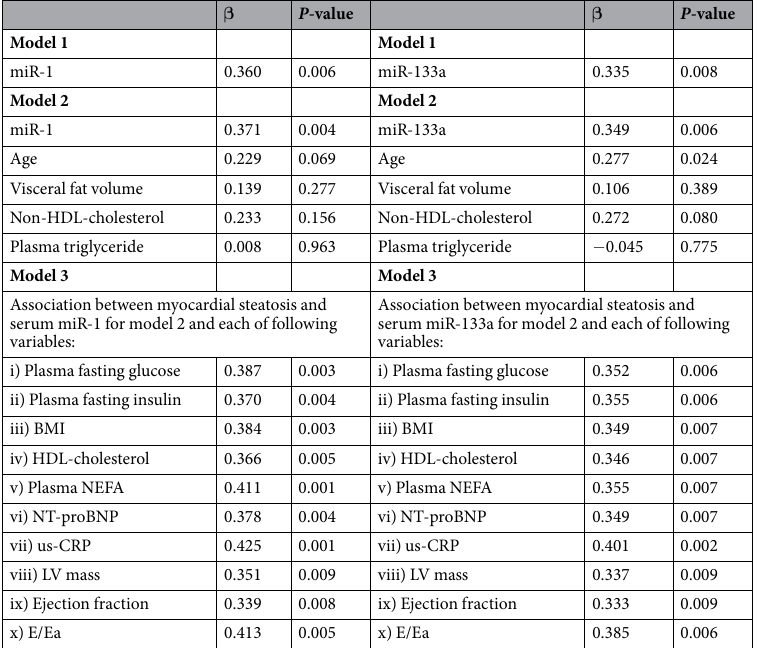
our clinical findings in an animal model of insulin resistance induced by a high-fat diet. Body composition and biochemical parameters for both groups of animals are shown in Table S2 (Supplementary Information). Six weeks of Western diet significantly increased fasting plasma glucose and insulin levels, as well as the insulin resist- ance index (HOMA-IR) (Fig. 2A). A glucose tolerance test in mice fed on a Western diet revealed delayed glucose clearance as compared with those fed on a chow diet. As expected, the accumulation of neutral lipid content in the myocardium was significantly higher in mice fed on a Western diet as compared with those on a normal chow diet (Fig. 2B). No differences in cardiac function parameters were observed between study groups (p < 0.050 for all parameters). After demonstrating an increase in myocardial neutral lipid accumulation in our murine model of insulin resistance, we next analysed levels of miR-1 and miR-133a in the serum and myocardium of both diet groups. Corroborating our clinical findings, we observed increases in serum levels of miR-1 (3.3-fold) and miR-133a (2.4-fold) in the Western diet group with respect to the chow diet group (Fig. 2C). Myocardial levels of miR-1 and miR-133a were similar in both groups (Fig. 2D). A correlation between the myocardial neutral lipid content and circulating levels of miR-1 and miR-133a was observed ( ρ = 0.622, P = 0.031, ρ = 0.755, P = 0.005, respectively). Circulating cardiomyocyte-enriched miR-1 and miR-133a are released by HL-1 cardiomyo - cytes following intracellular neutral lipid accumulation. Our clinical and in vivo findings suggest that lipid oversupply to the myocardium may underlie the observed alterations in serum miR-1 and miR-133a levels. Therefore, we used an in vitro model to investigate whether the accumulation of neutral lipids in HL-1 cardiomyocytes induces the release of miR-1 and miR-133a. As previously demonstrated by our group 28, 29 , expo- sure to VLDL + IDL (50 or 100 μ g/mL) dose-dependently increased intracellular neutral lipid content (Fig. 3A). Intracellular neutral lipid accumulation did not induce cardiomyocyte apoptosis (Supplementary Information, Figure S1), in agreement with previous findings of our group 28, 29 . To determine whether intracellular neutral lipid accumulation influences miRNA release from cardiomyo- cytes, miRNA levels were analysed in exosomes collected from conditioned medium before and after cardiomyo- cyte exposure to lipoproteins. The isolated exosomes were subjected to transmission electron microscopy, which revealed small, rounded vesicles ( < 0.1 μ m) surrounded by a bilayered membrane (Supplementary Information, Figure S2A). The exosome marker CD63 was detected by immunoblotting (Supplementary Information, Figure S2B) and the presence of small non-coding RNAs was corroborated (Supplementary Information, Figure S2C). In agreement with previous findings, VLDL + IDL dose-dependently induced the release of miR-1 (27.5-fold and 33.9-fold increases for 50 and 100 μ g/mL, respectively) and miR-133a (11.4-fold and 12.6-fold increases for 50 and 100 μ g/mL, respectively) from HL-1 cells into the culture medium (Fig. 3B). To further characterize the response of cardiomyocyte-enriched miRNAs to lipid loading, we also evaluated the intracellular profiles of both miRNAs. We observed increased expression of miR-1 (2.4-fold and 2.6-fold for 50 and 100 μ g/ mL, respectively) and miR-133a (1.3-fold and 1.6-fold for 50 and 100 μ g/mL, respectively) after exposure to lipo- proteins as compared with control conditions. A dose-dependent response was specifically observed in miR-133a intracellular levels (Fig. 3C).